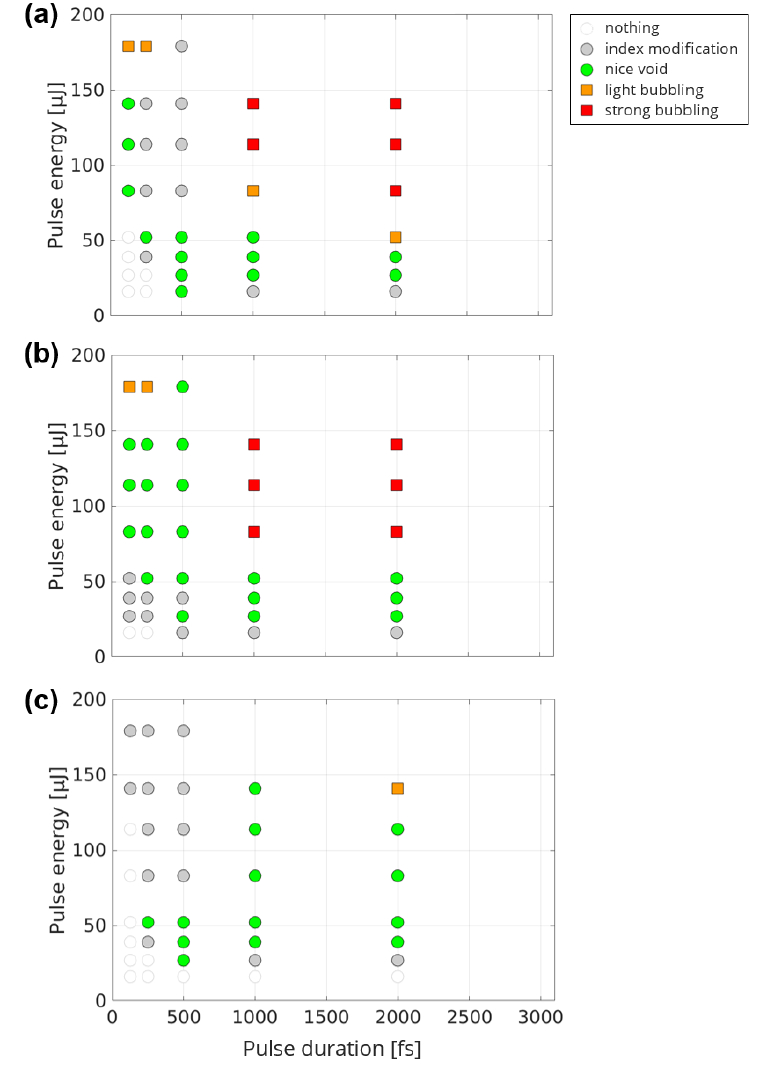
Figure 5. Morphology of single shot-induced damage in fused silica as a function of pulse energy and pulse duration. This is performed for a Bessel beam position: ( a ) at center of sample, ( b ) crossing the entrance surface, ( c ) crossing exit